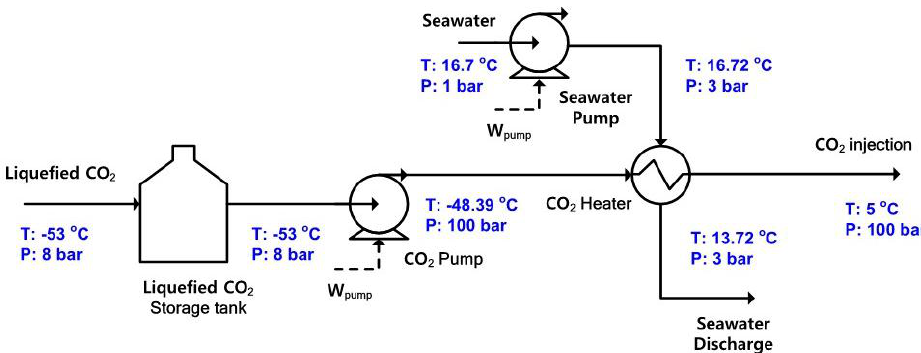
Figure 1. Conventional injection system.